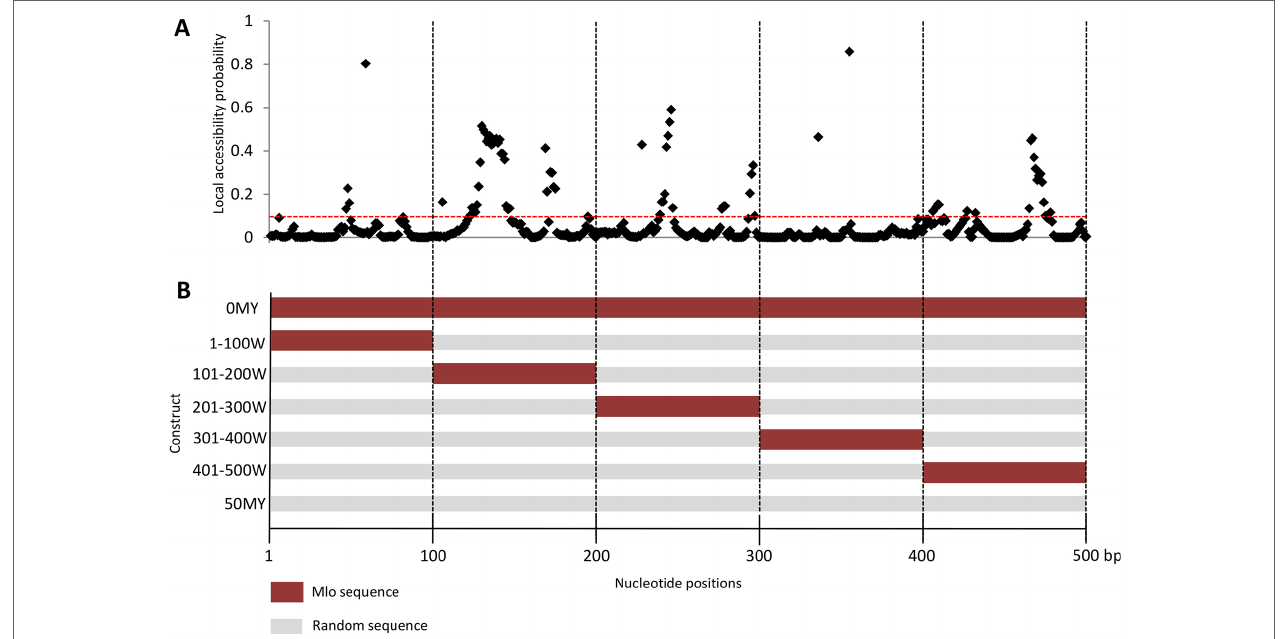
FIGURE 2 | (A) Local accessibility probability (LAP, on the y-axis; parameters u = 8, L = 40, W = 80) of the target region of the HvMlo gene. Red-dotted line indicates the default si-Fi LAP threshold of 0.1. Please note that a high LAP is required but not sufficient condition for an efficient RNAi, and the height of the peak is probably not as decisive as long as it is higher than the threshold. (B) RNAi trigger sequence design of the 100-bp window constructs. The sequences of the 100-bp window constructs are derived from the 0MY (perfectly matching to the HvMlo target gene) and 50MY (completely randomly generated sequence) constructs as indicated by the colors (same colors stand for identical sequences in the specified